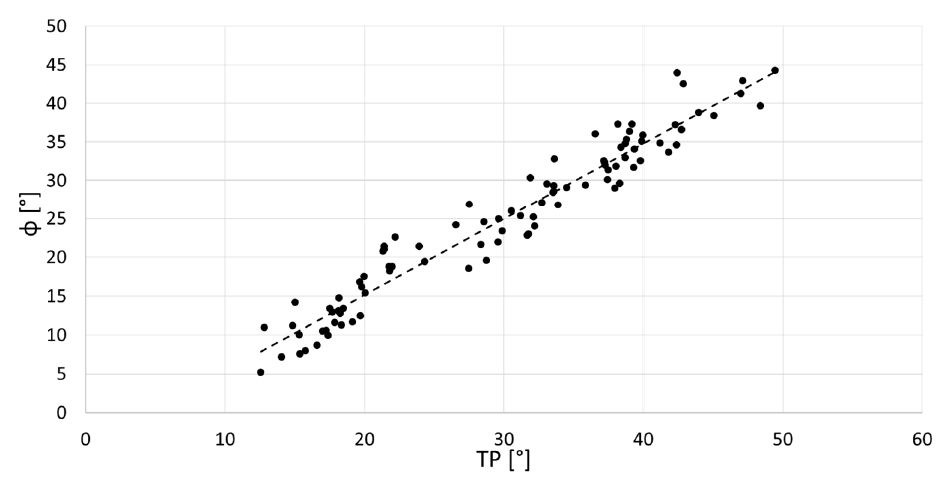
Figure 5. Linear trend of ϕ with respect to TP depicting the strong association between these two variables.